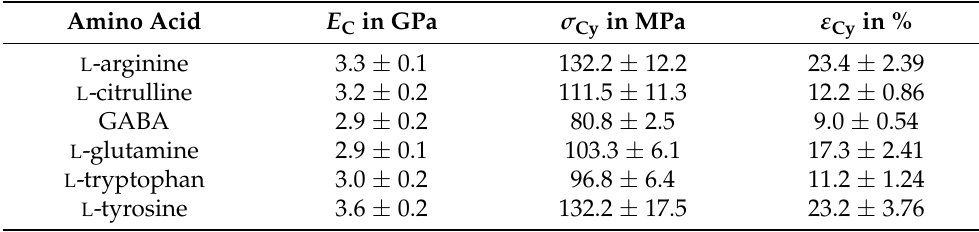
Table 5. Compression modulus E C , compression yield strength a σ Cy , and compression yield strain ε Cy of amino-epoxides (average ± standard